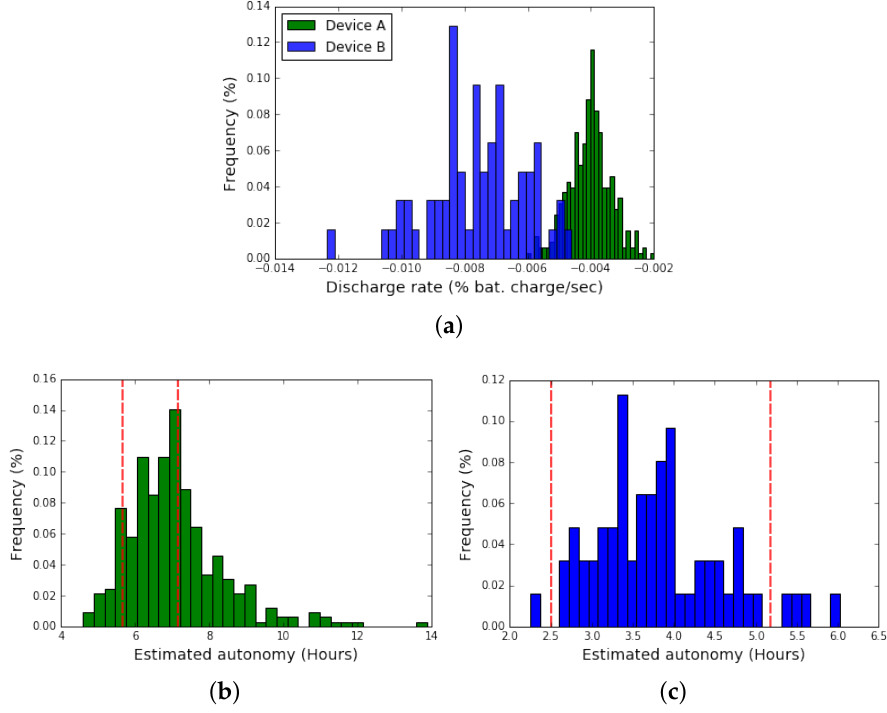
Figure 6. Discharge rate distribution and estimated autonomy analysis. ( a ) Discharge rate distribution for devices of type A and B. ( b ) Estimated autonomy for devices of type A. ( c ) Estimated autonomy for devices of type